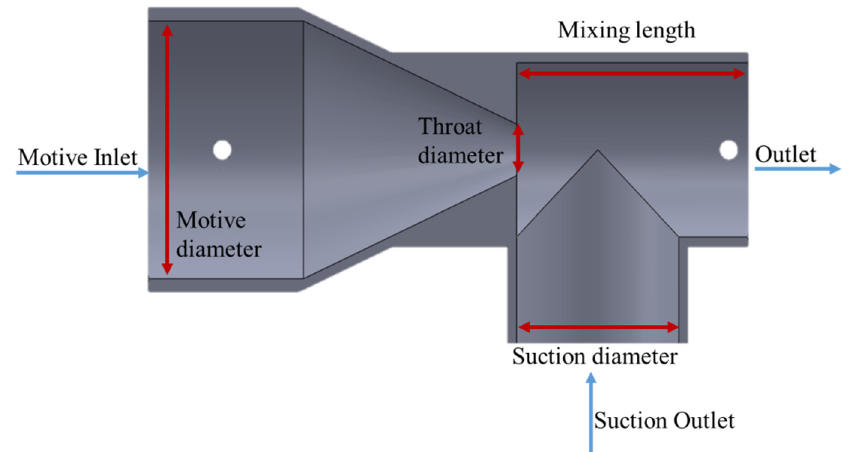
Figure 1. Cross-section of representative nozzle with key geometric parameters identified.